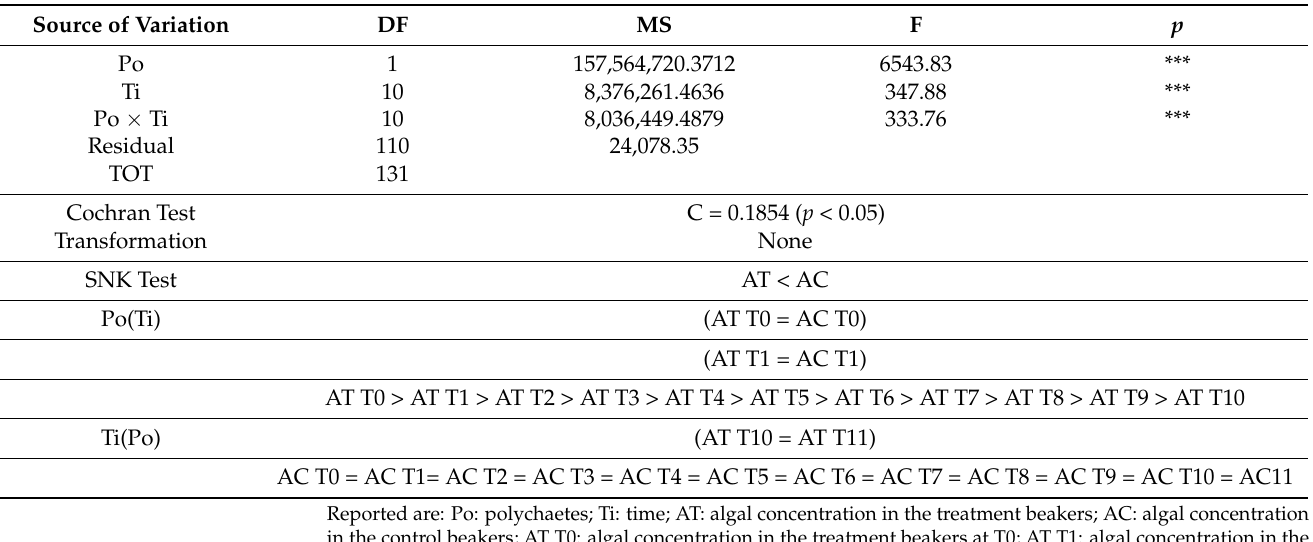
Table 1. Summaries of ANOVA testing for differences in average Amphidinium carterae abundances measured at the different sampling times in the control and treatment beakers with Sabella spallanzanii .